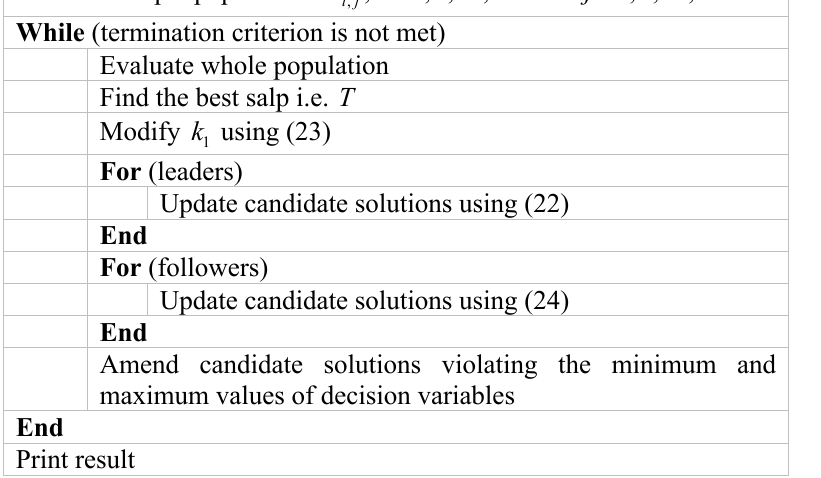
Figure 4. Pseudo code of SSO